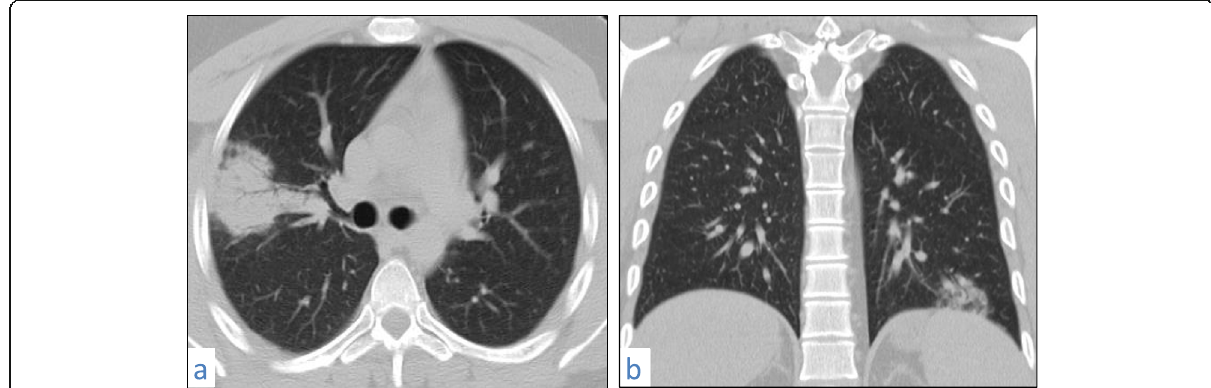
Fig. 7 A 31-year-old male patient with COVID-19, CT chest axial image ( a ) shows right upper lobe predominantly subpleural consolidation with